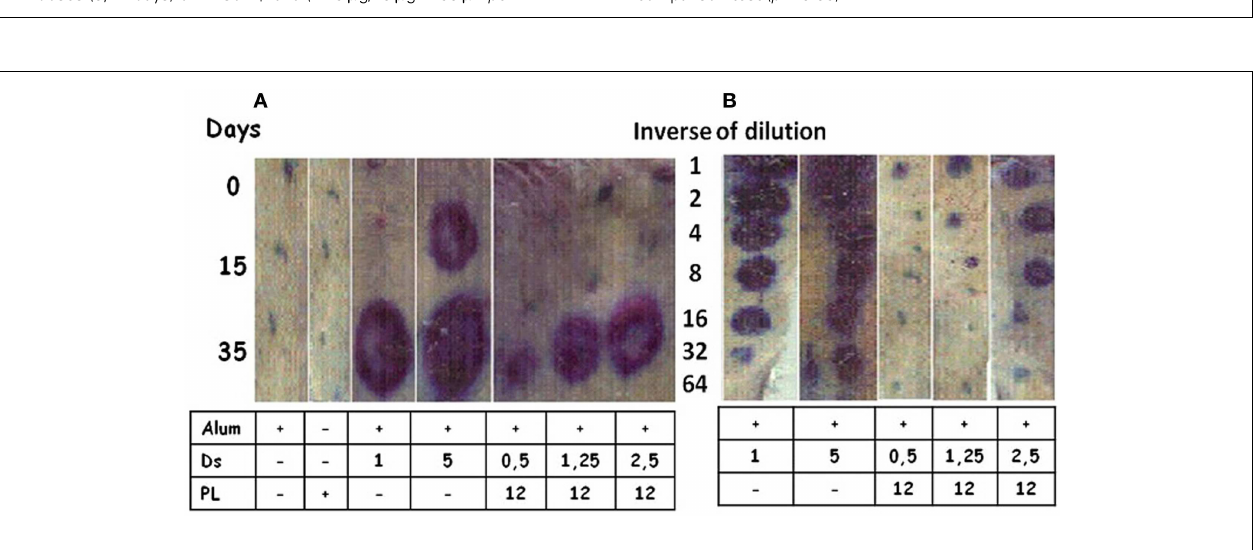
0.5–2.5 µ g per dose. Controls included AFPL1 or Alum alone. Sera were prepared at 0, 15, and 35days. After 48h, Evans Blue plus 1mg of Ds was inoculated intravenously.Then the rats were sacrificed and the skin was used to evaluate the density and diameter of the stain. (A) Shows the evaluation of undiluted sera and (B) the quantity of the specific IgE dilution in the